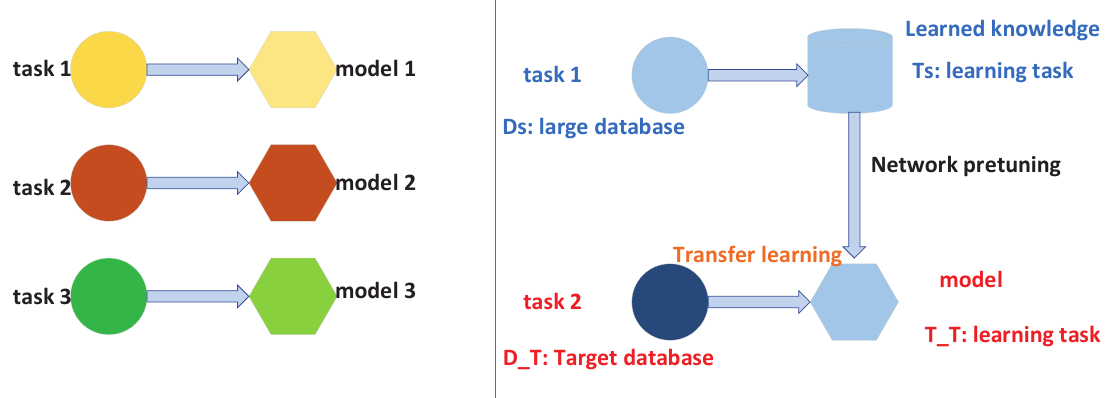
Figure 8. The comparison of two different learning methods. The learning method on the left is that every new leaning should start from zero. The learning method on the right is that each new learning is based on the previous experience, and it does not require a large training